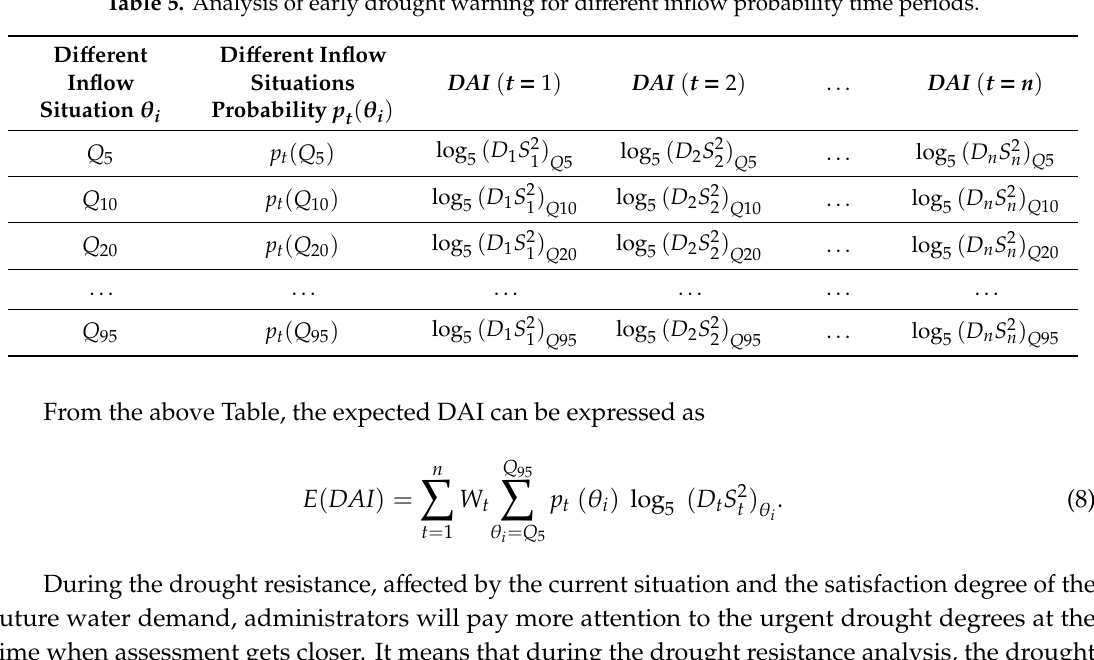
Table 5. Analysis of early drought warning for di ff erent inflow probability time